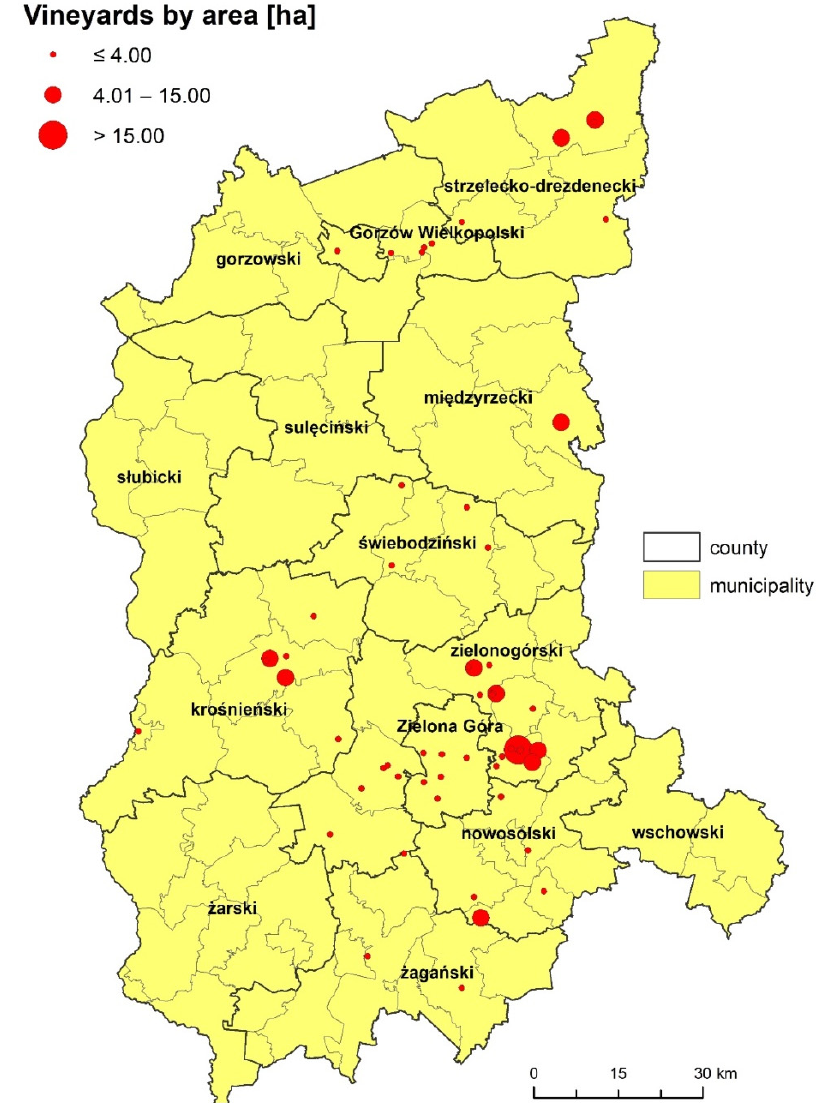
Figure 4. Distribution of vineyards in Lubuskie Region in Poland in 2021. Source: own study based on the data from National Support Centre for Agriculture and own research.